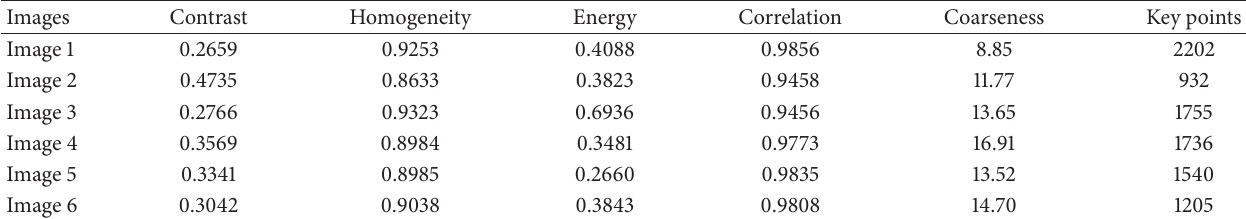
Table 2: Second-order textural features with coarseness and key points for few images.